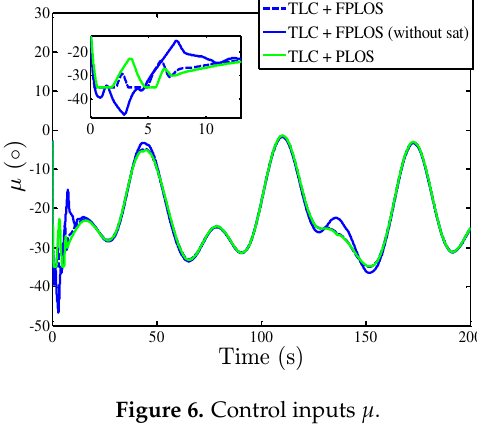
Figure 6. Control inputs µ .